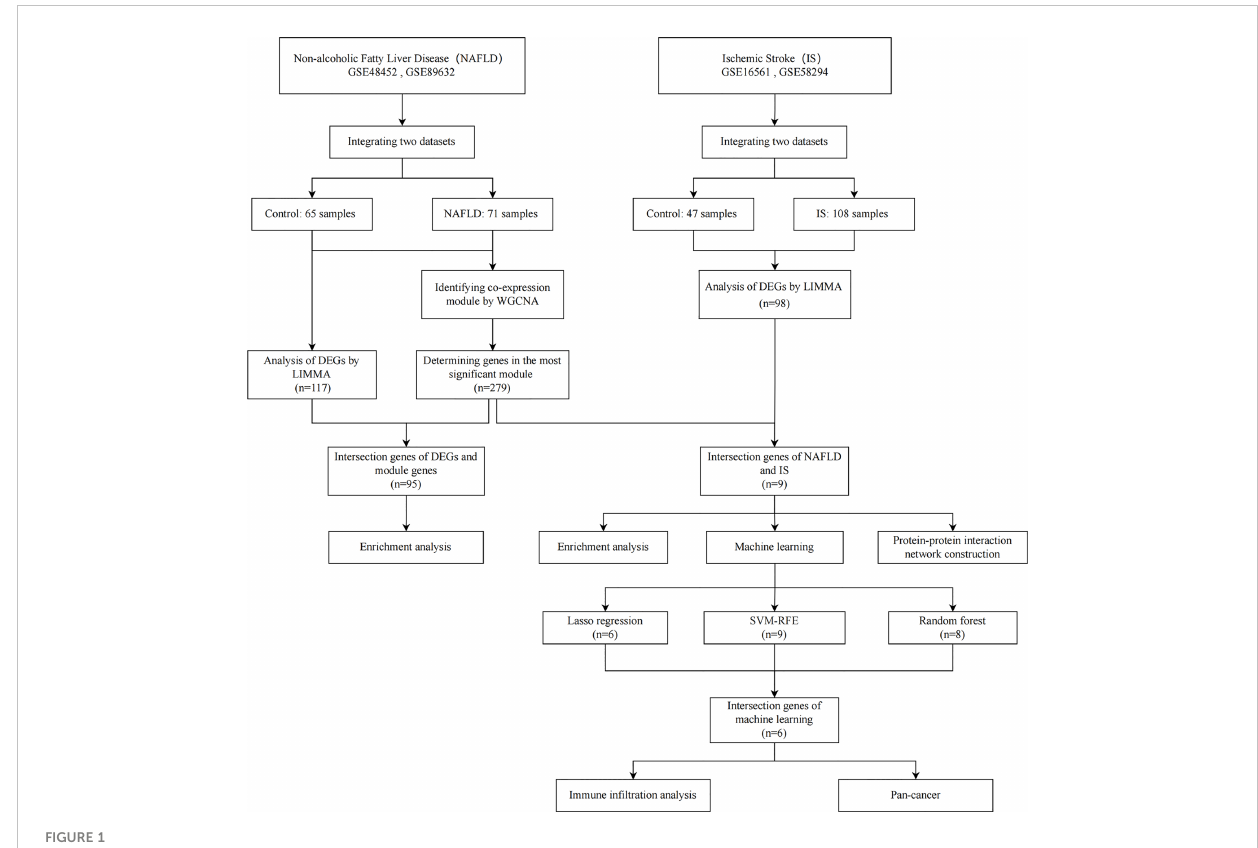
FIGURE 1 Depiction of the study fl ow